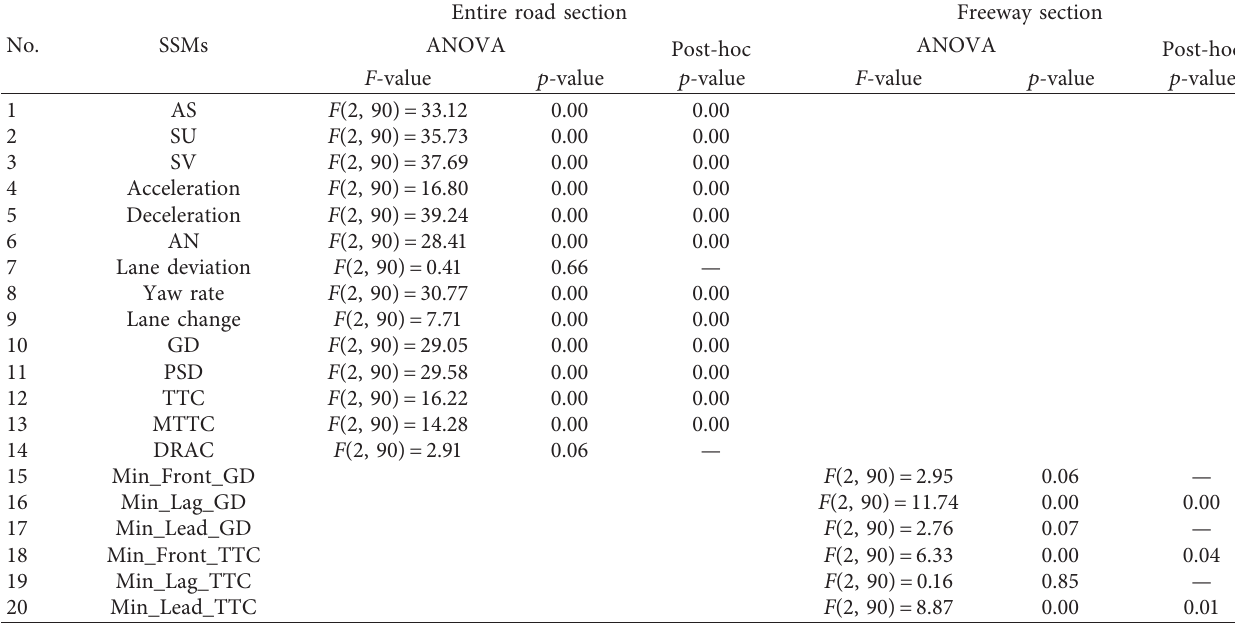
Table 3: Summary of statistics for surrogate safety measures in sensitivity